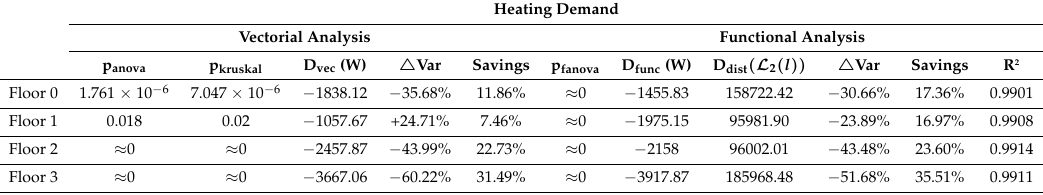
Figure 7. Analysis of the heating demands of each floor measured in W. In the first row, the vectorial results (in form of box plots) are presented. In the second row, instead, the functional data are represented with the respective mean functions. The data are divided into winter days before and after the refurbishment. Table 4. Numerical results on each floor results for heating demands. The vectorial results are presented with D vec measuring the difference between medians. The functional results, accompanied with the average minute difference (D func ), the L 2 ( l ) distance between the mean functions (D dist ) and the smoothing adjustment (R 2 ), are also presented. For both analyses, the change in the variability of the data ( (cid:52) Var) and the heating savings are displayed. Lastly, the p -values for the tests, both vectorial and functional, are